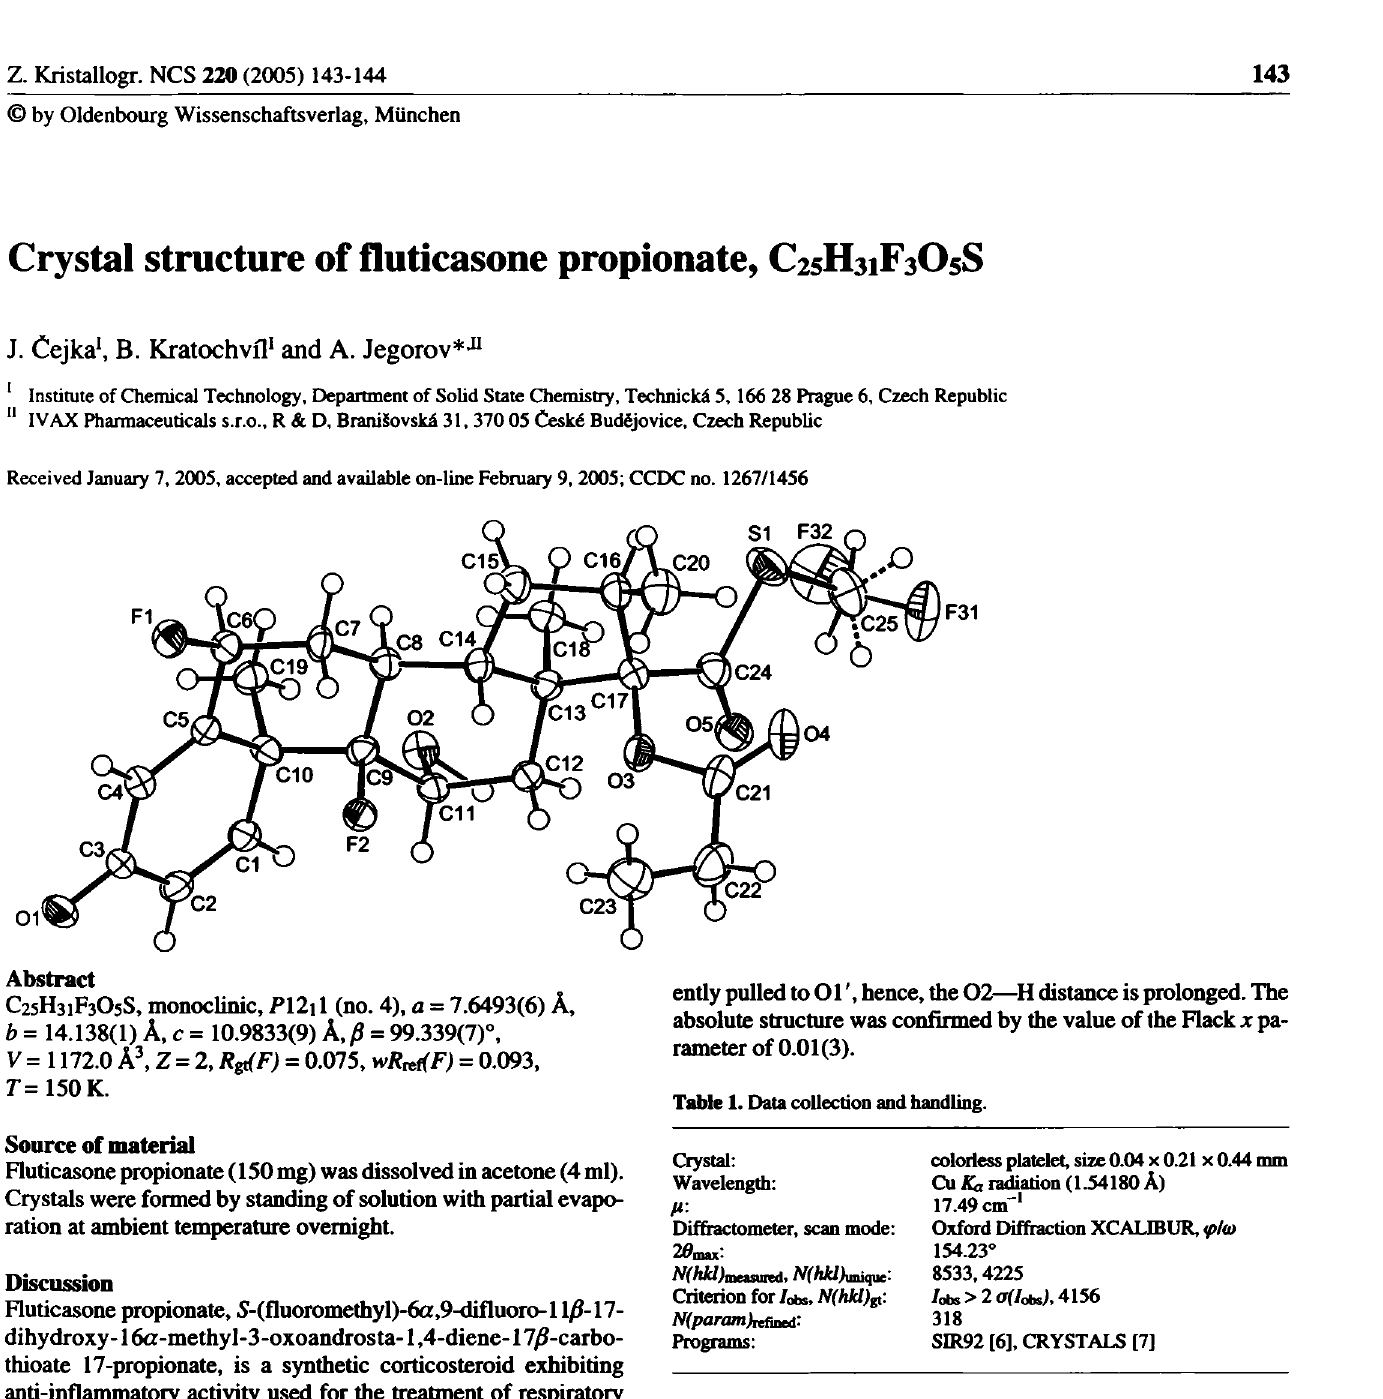
Table 2. Atomic coordinates and displacement parameters (in Ä 2